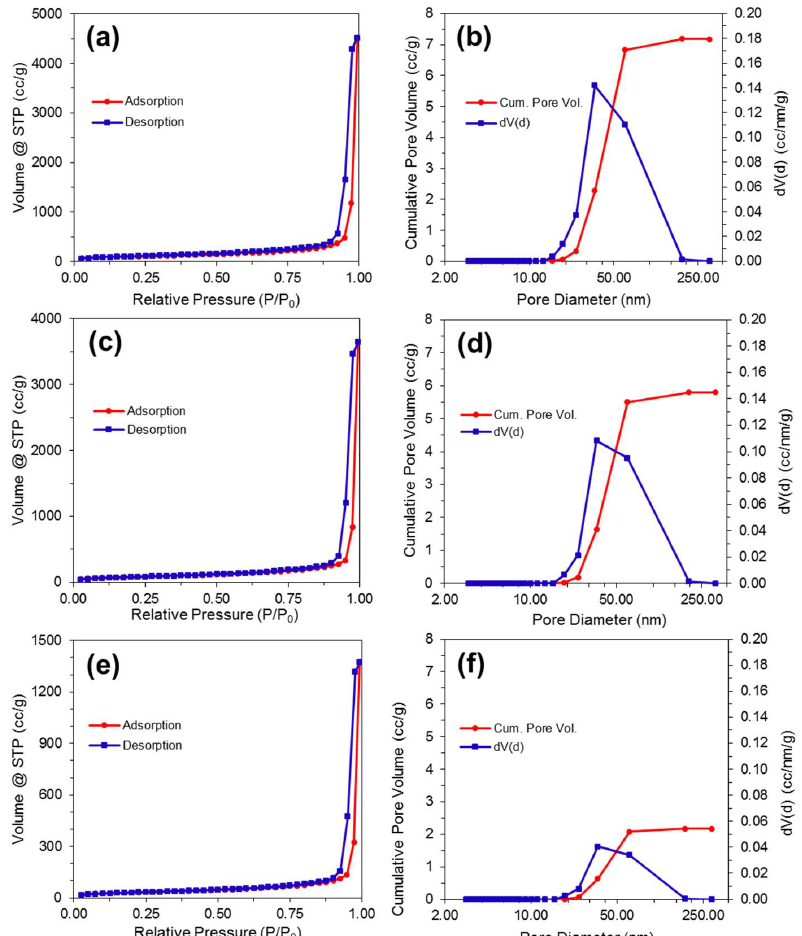
Figure 6. BET analysis. Nitrogen adsorption–desorption isotherms, and pore size distribution with cumulative pore volume for aerogels synthesized with palladium Pd(NH 3 ) 4 Cl 2 salt solutions of ( a ),( b ) 0 mM; ( c ),( d ) 100 mM; ( e ),( f ) 1000 mM.